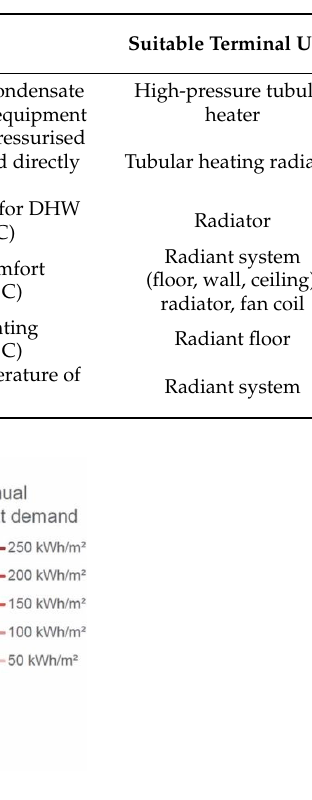
Table 2. The five types of district heating networks.